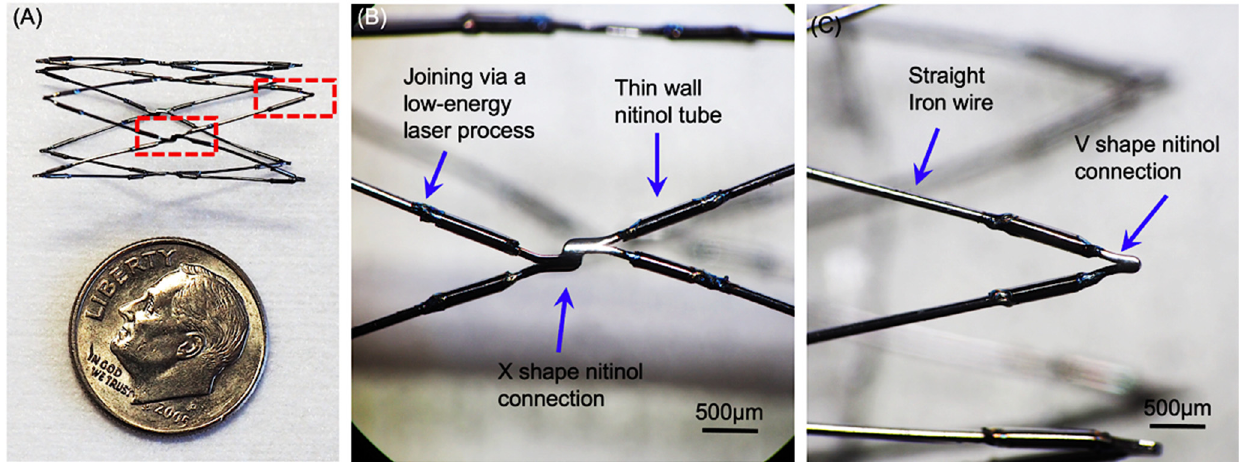
Figure 9. Prototype valve frame and details: ( A ) entire valve frame, ( B ) the nitinol and iron wire integration using a thin-wall nitinol tube for the middle connection, and ( C ) the end section device details with “V”-shaped nitinol connection.